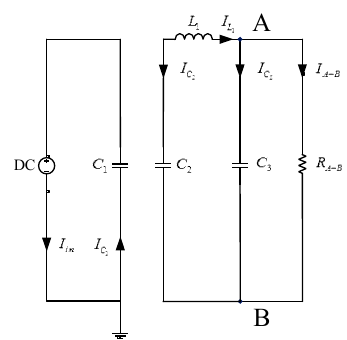
Figure 7. Equivalent circuit diagram of open status of constant-current (CC) isolation circuit.